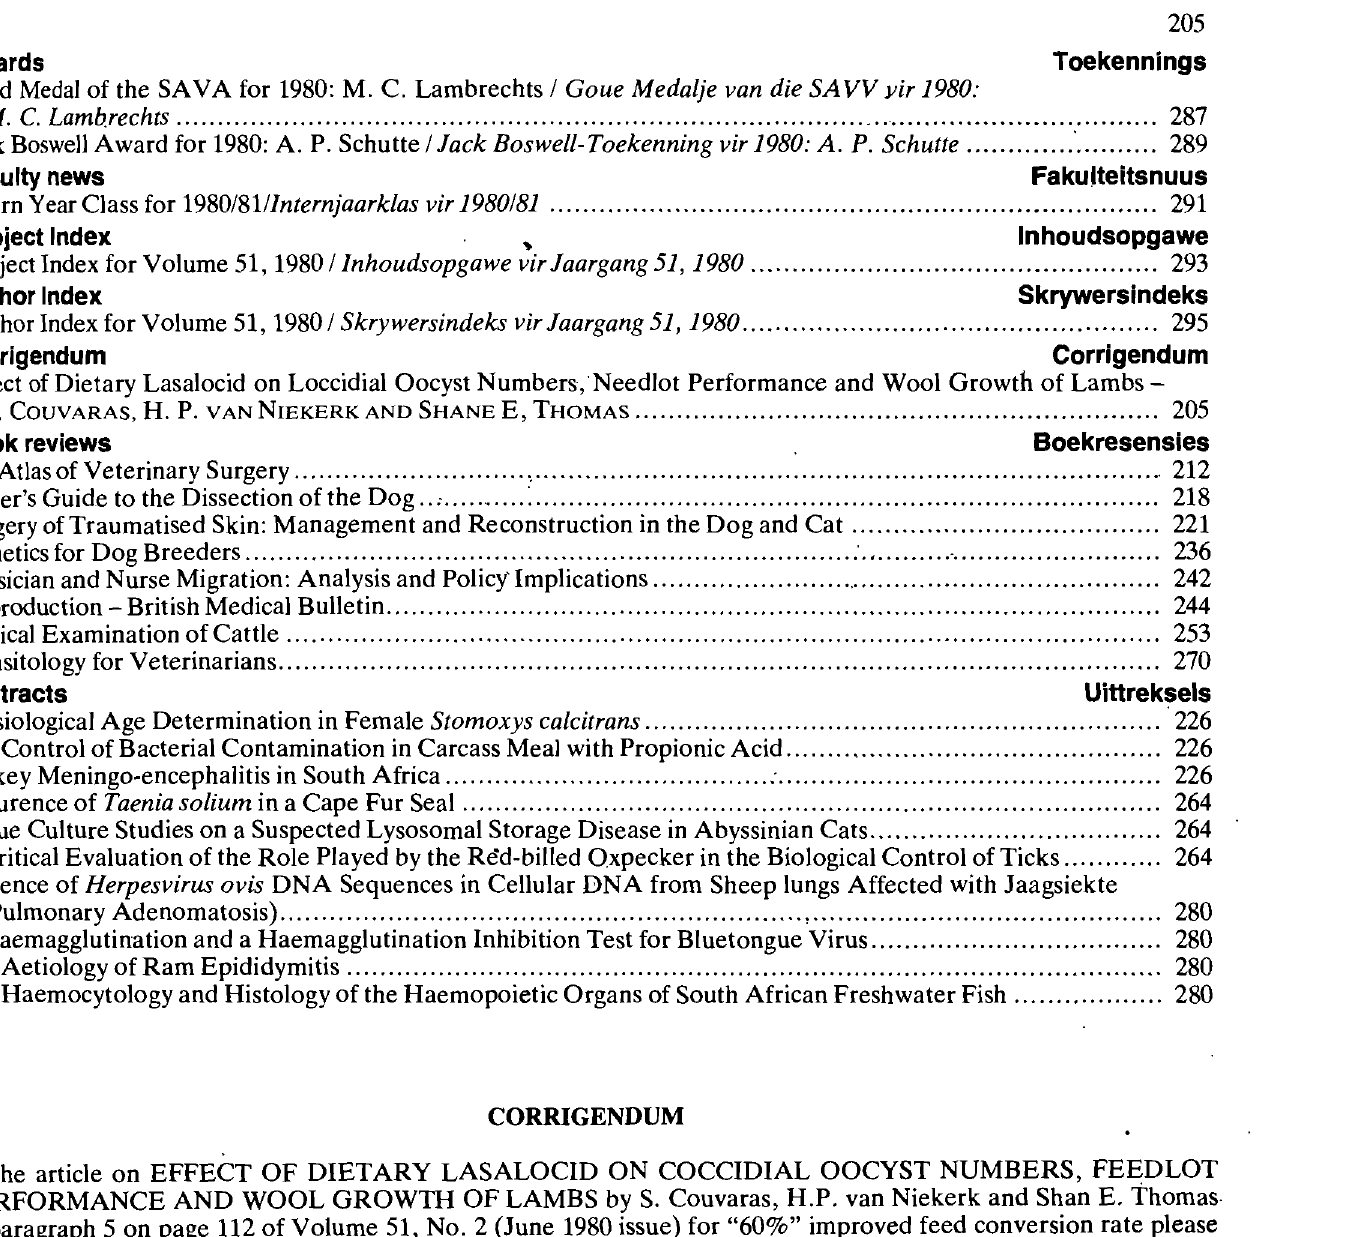
Gold Medal of the SA V A for 1980: M. C. Lambrechts 1 Goue Medalje van die SAVV )lir